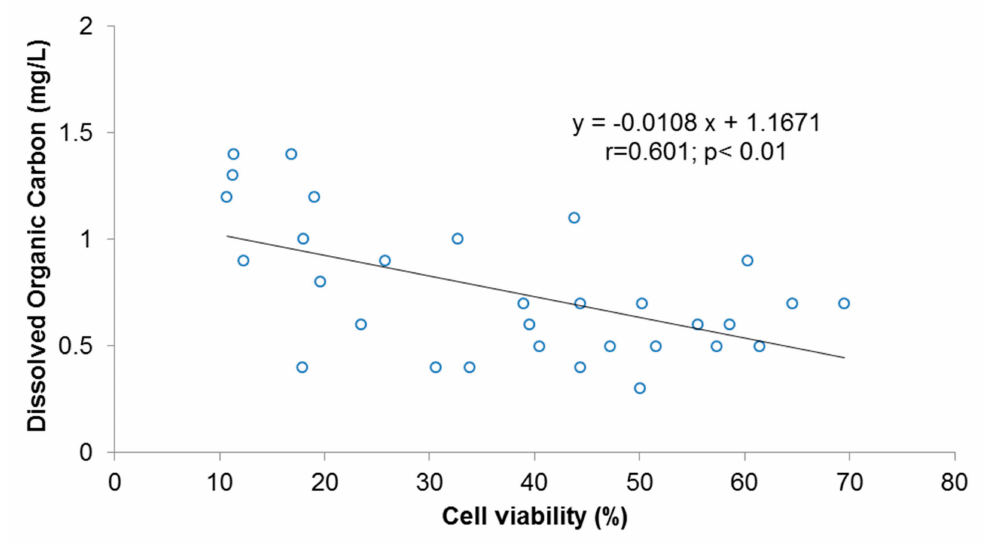
Figure 5. Linear regression (n = 34) which shows the relationship between the cell viability and dissolved organic carbon (DOC).